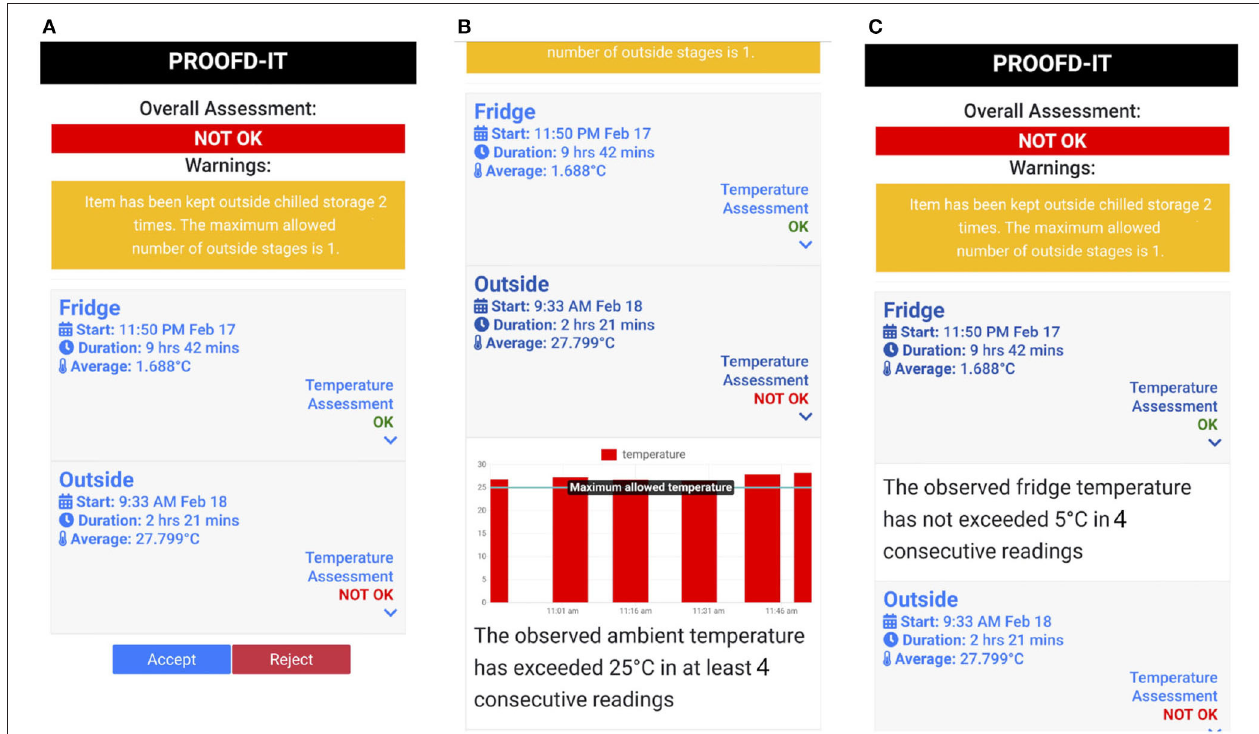
FIGURE 5 | Mobile app screenshots displaying two delivery stages recorded by the IoT monitor. Screenshot (A) shows a high-level overview of the compliance report; screenshot (B) shows an expanded view of a non-compliant stage with sample temperature readings that violated the temperature threshold; screenshot (C) shows an expanded view of compliant stage with a summary